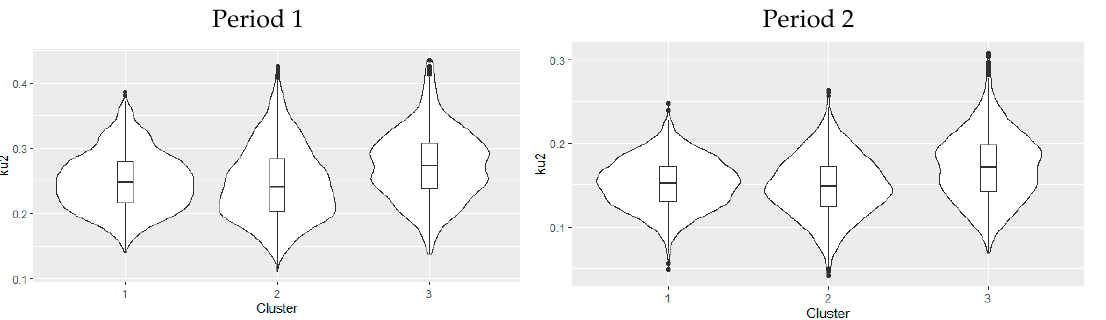
Data marked in red: the null hypothesis is true, which means values do not change between periods.